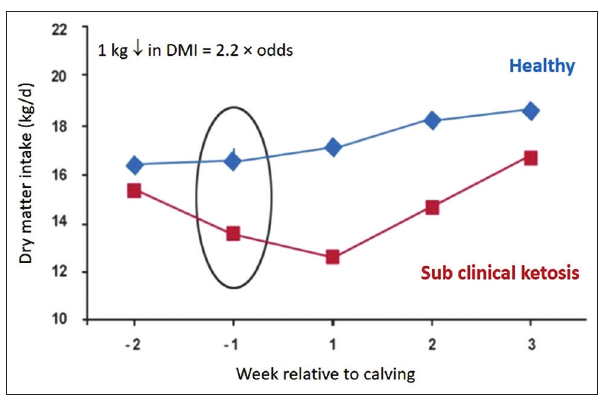
Figure 4: Early detection of endangered cows in the dry phase